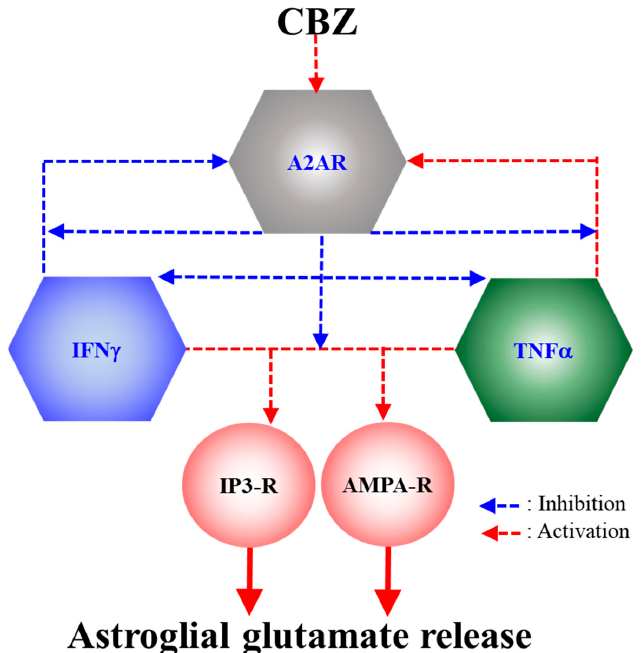
Figure10. Our proposed hypothesis forthe mechanisms of CBZon astroglial glutamatergictransmission associated with A2AR. Chronic exposure to IFN γ and TNF α suppresses and enhances astroglial A2AR expression, respectively; however, chronic activation of astroglial A2AR inhibits the expressions and responses of IFN γ and TNF α . Both IFN γ and TNF α enhance astroglial transmission via activations of IP3-R and AMPA-R. Chronic administration of CBZ suppresses the stimulatory e ff ects of IFN γ and TNF α on astroglial glutamatergic transmission via its A2AR agonistic